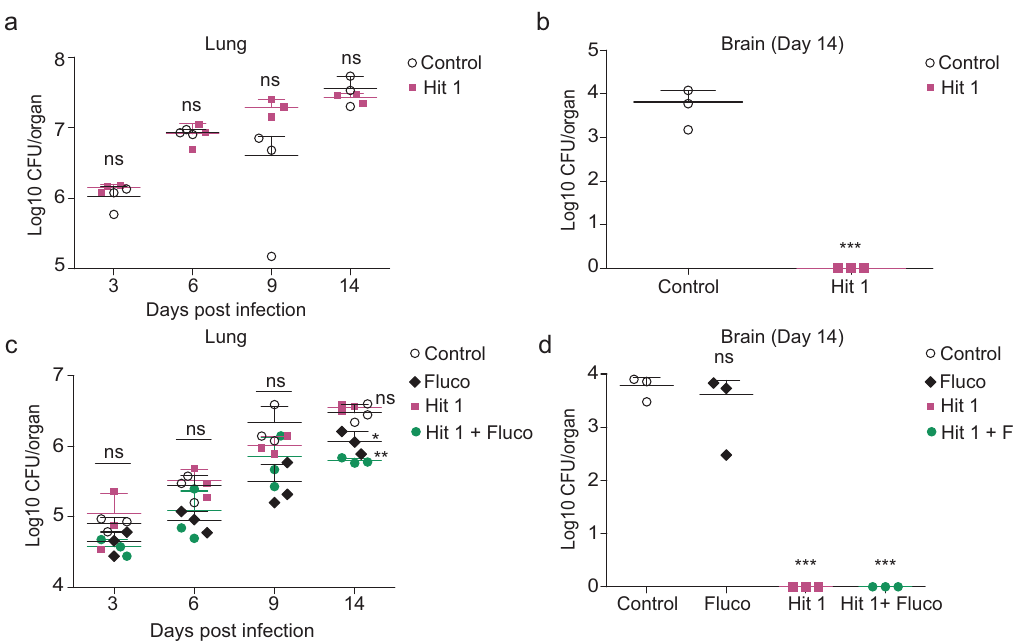
Fig. 6 Hit 1 prevents brain dissemination in a mouse model of cryptococcosis. a Female CBA/J mice were inoculated with 1 × 10 6 Cryptococcus neoformans H99 cells in log phase and the treatment started at the same day of infection via intraperitoneal (IP) with 10 mg/kg/day of hit 1. The CFU was recovered from the lungs at days 3, 6, 9, and 14 after infection and there was no signi fi cant difference among untreated and treated mice. n = 3 mice for each group. Statistical analysis by one-way ANOVA, Tukey ’ s multiple comparison test. ns p > 0.05. b No yeast cells were recovered from the brain after 14 days of infection from mice treated with hit 1. n = 3 mice for each group. Statistical analysis by unpaired Student ’ s t -test. *** p < 0.001. c Mice were inoculated with